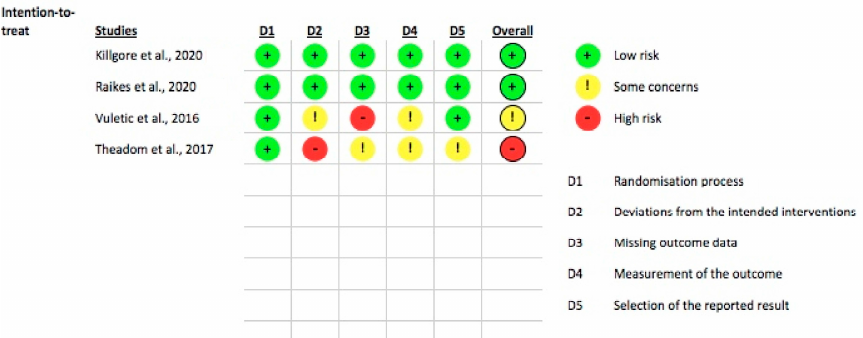
Figure A2. Risk of Bias for each study included in the Section 3.2, assessed using the Cochrane Rob2 tool revised version [37,38,40,44].